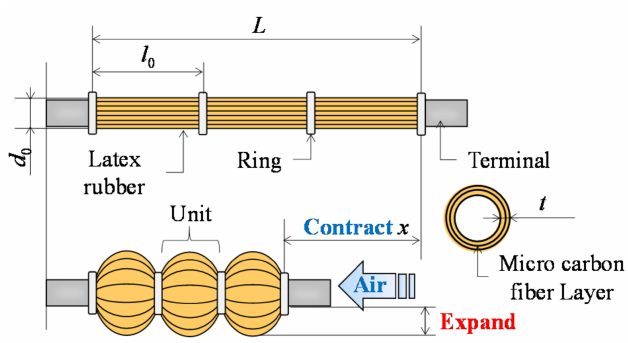
Figure 2. Straight-fiber-type artificial muscle